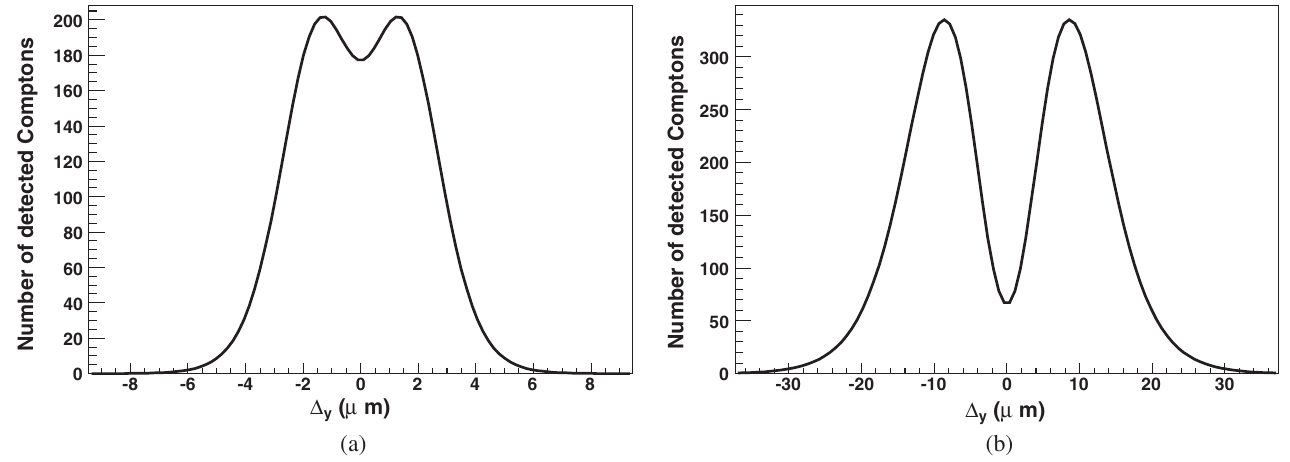
mode and focused 01 (cid:1) 1 (cid:3) m , (cid:2) (cid:1) 10 (cid:3) m . (b) (cid:2) (cid:1) 5 (cid:3) m , (cid:2) (cid:1) ey ex ey ex